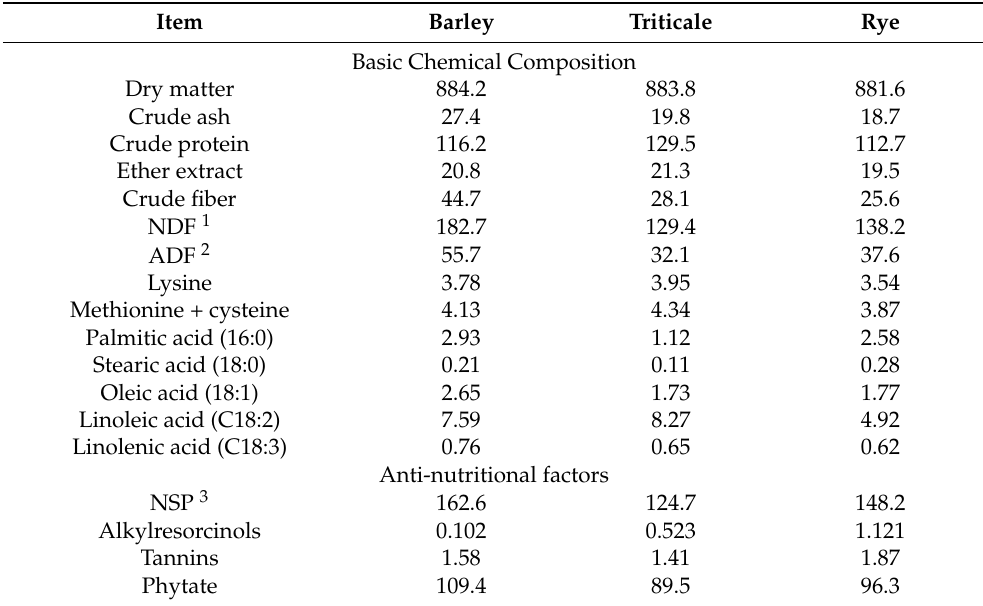
Table 2. Chemical composition of cereals grain, including the anti-nutritional factors content (g/kg). Item Barley Triticale Rye Basic Chemical